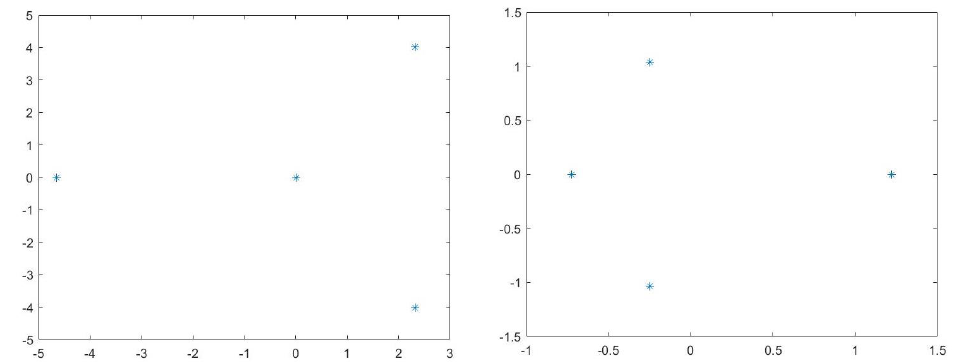
Figure 1. λ = 1 ( left ) and λ = 10 ( right ). P ( s ) roots evolution in the complex domain (Real part in the horizontal and Imaginary in the vertical) for a = 1, with χ 1 < (cid:101) → 0 and | x | δ (cid:101) = 1. It shall be noted that there exists at least one root Re ( s ) > 0.